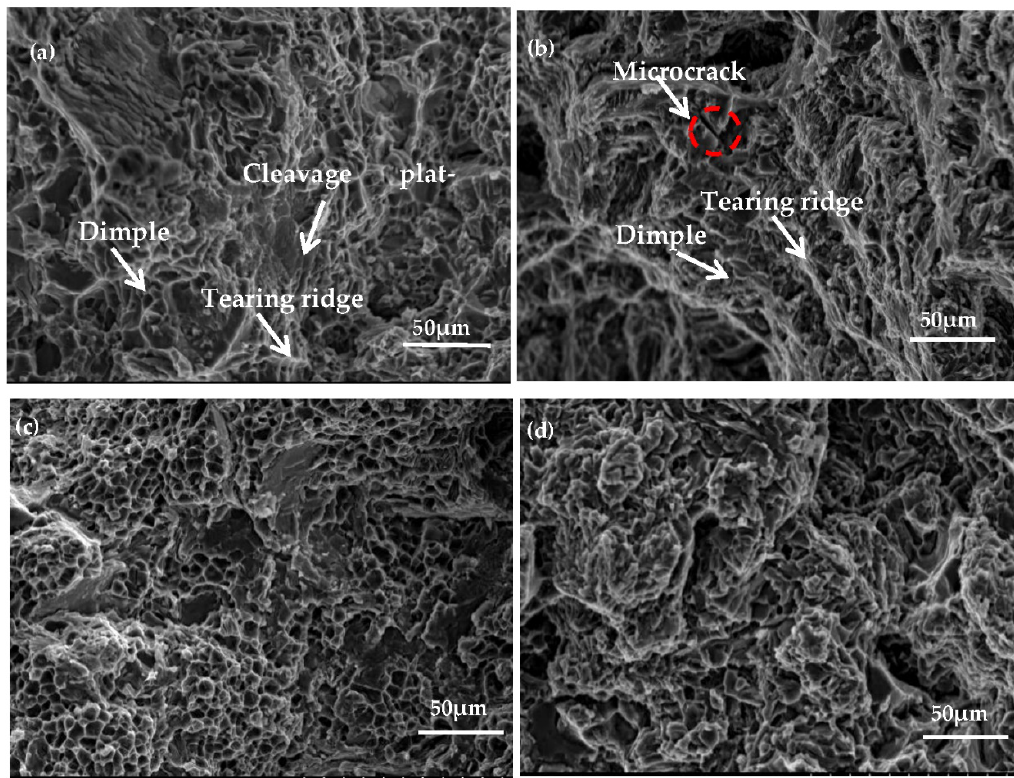
Figure 12. Fracture morphology for the hypereutectic Al − 17Si − 4Cu − xMg alloy: ( a , c ) Al − 17Si4Cu − 0.5Mg under as-cast state under and peak-ageing state. ( b , d ) Al − 17Si − 4Cu − 2.5Mg under as-cast state under and peak-ageing